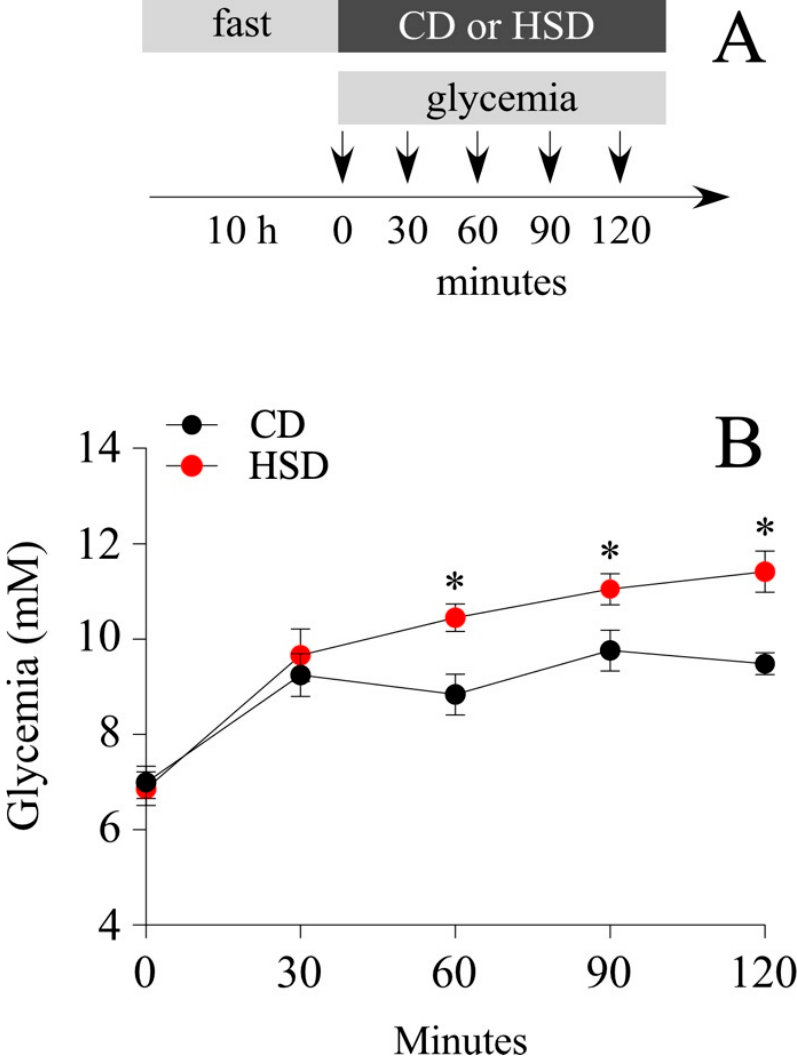
Figure 2. HSD-induced short-term glycemic changes. ( A ) After a 10 h fast (9 a.m. to 19 p.m.), male rats were fed ad libitum on the HSD and CD diets. Their glycemia was measured before and after feeding. ( B ) Variation in glycemia (mM) before and 30, 60, 90 and 120 min after the administration of the HSD and CD diets. n = 5 animals per condition; the data is represented as the mean ± sem; (*) p < 0.05; t -Student test.